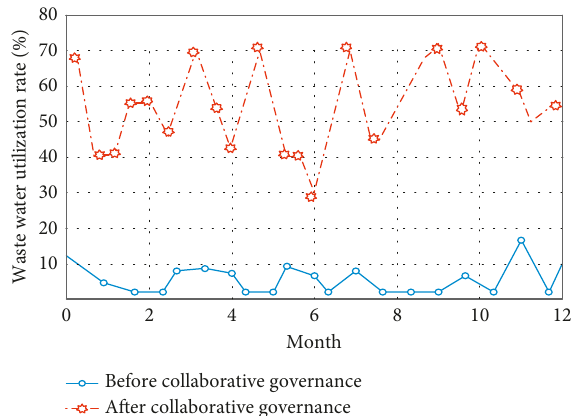
Figure 6: Comparison of wastewater utilization before and after adopting the designed